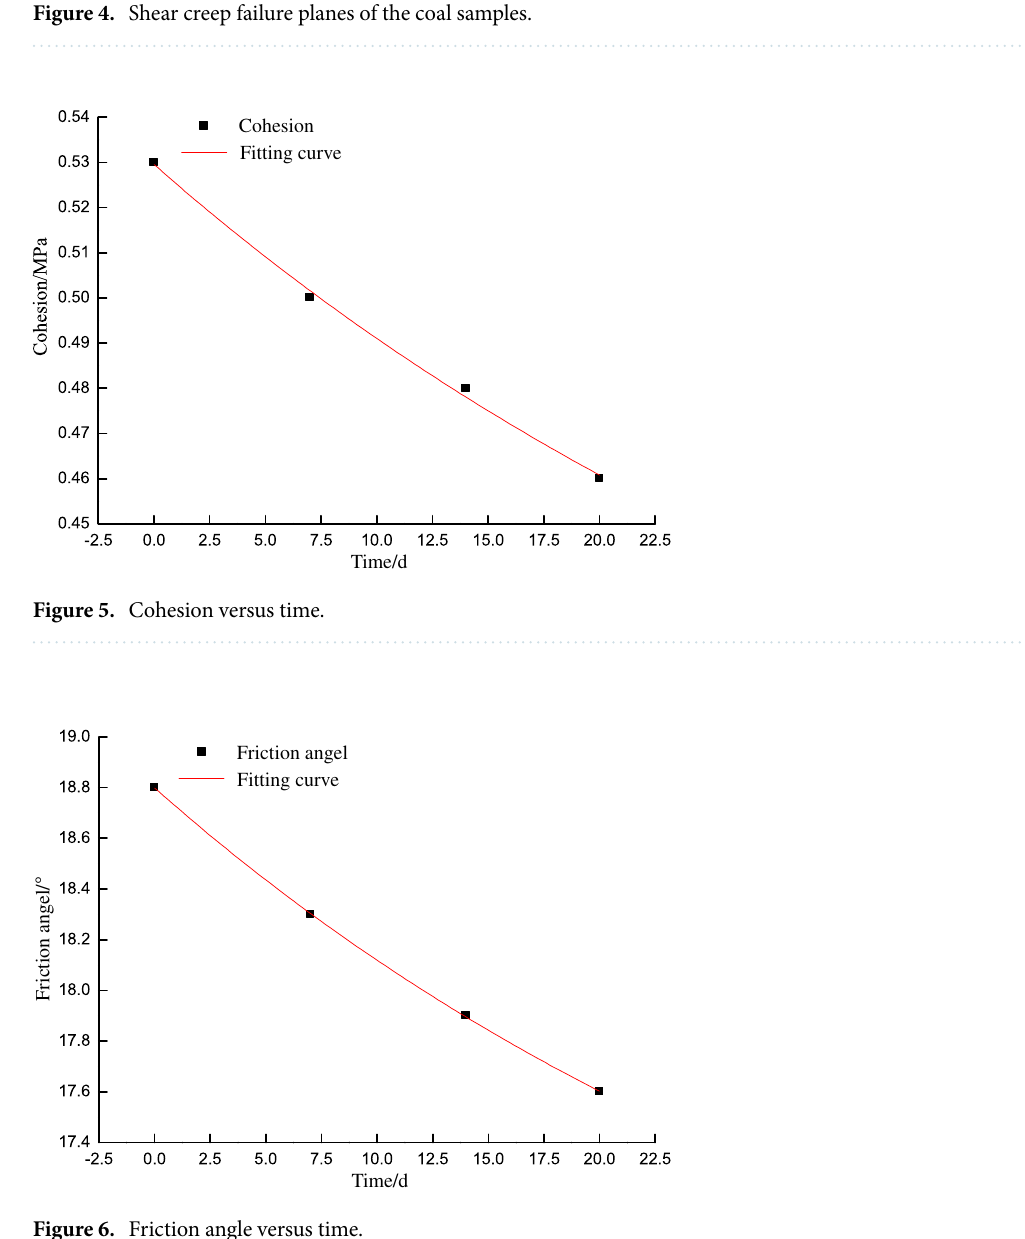
Figure 6. Friction angle versus